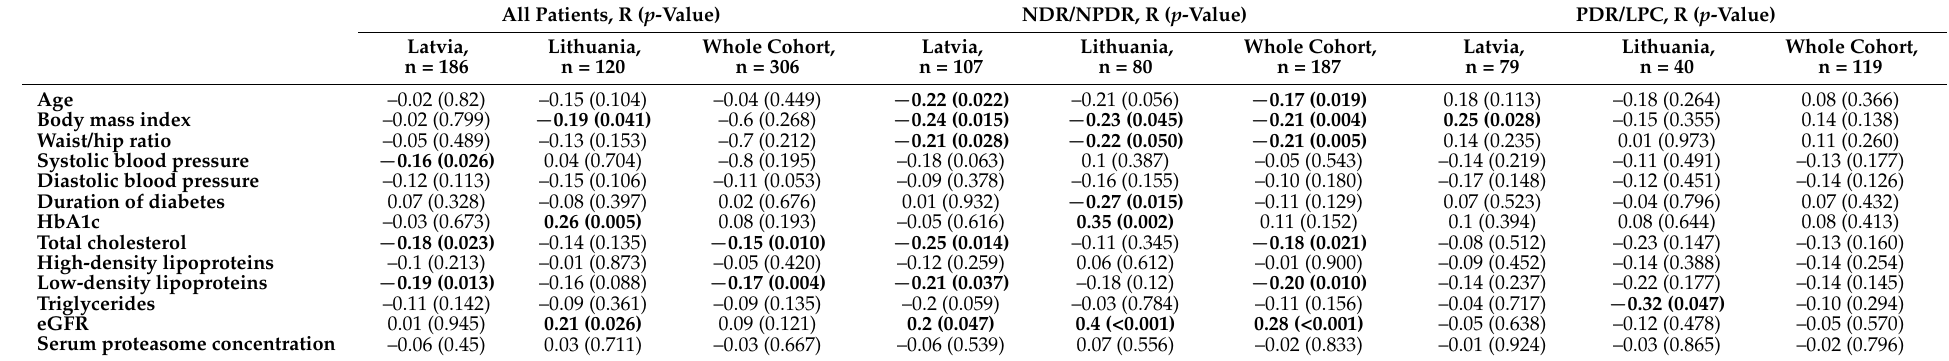
Table 3. Correlations between relative telomere length and clinical markers.